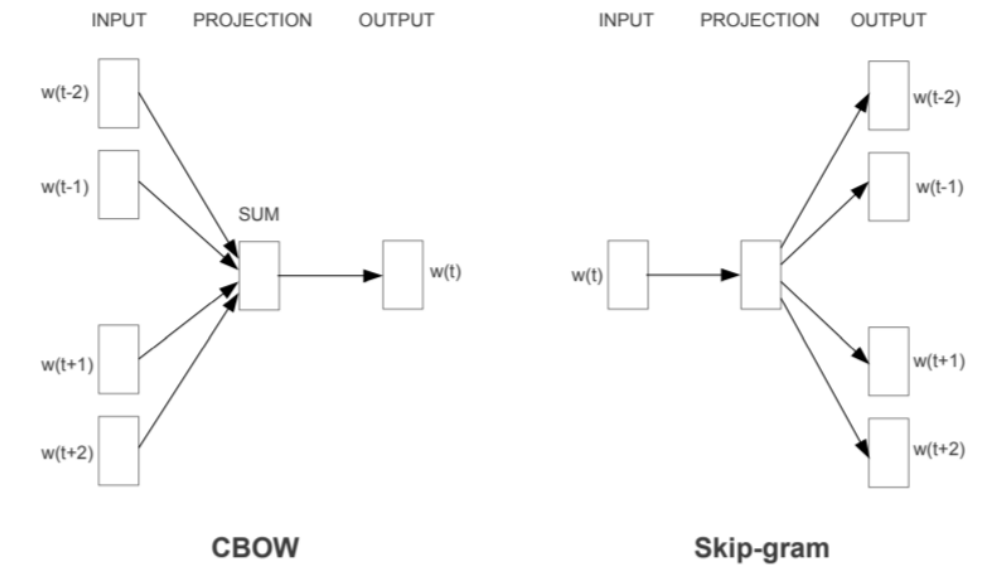
Figure 2. Architecture of CBOW and skip ‐ gram.